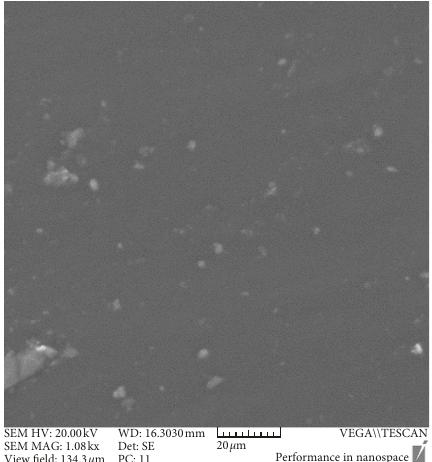
Figure 1: SEM micrographs of